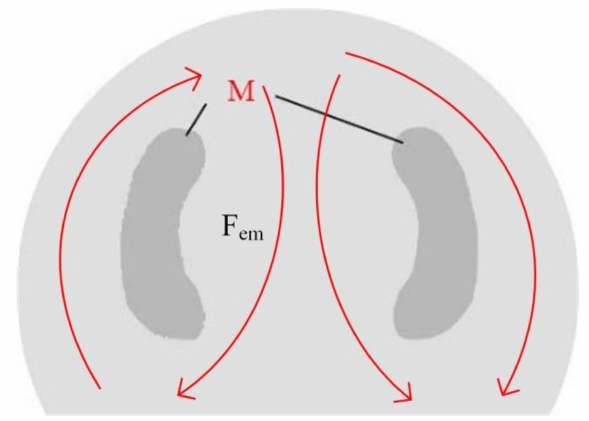
Figure 8. Dendritic distribution